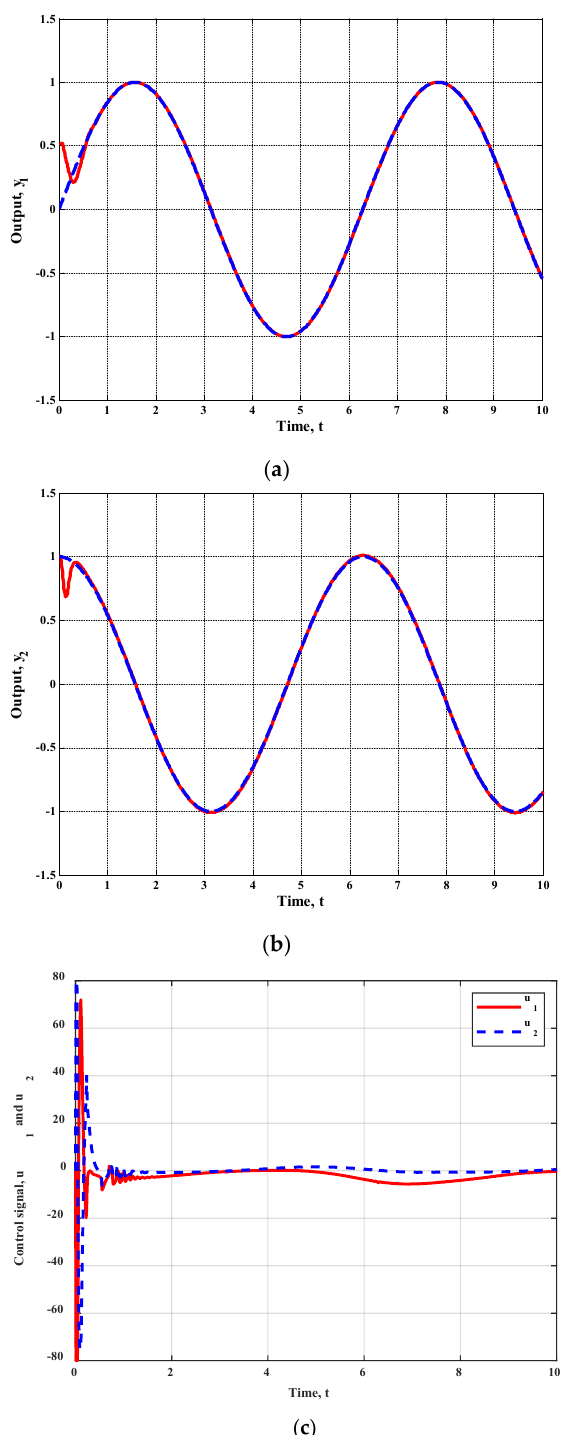
Figure 2. The output response of the hypothetical MIMO system controlled by ADRC based on LESO ( a ) output curve, y 1 , ( b ) output curve, y 2 , and ( c ) control signals, u 1 and u 2